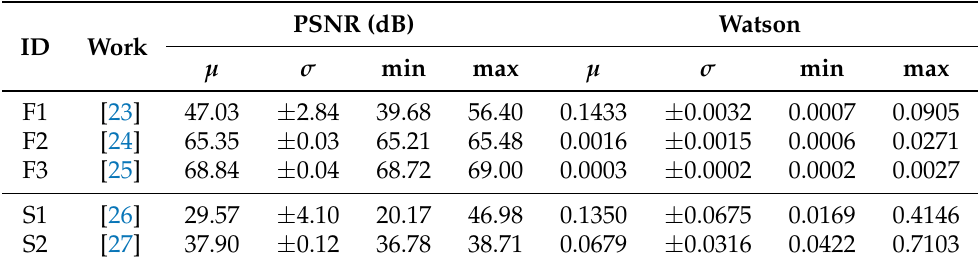
Table 2. Perceptual distortion performance for fragile reversible watermarking (F1, F2, and F3) and self-recovery schemes (S1 and S2).